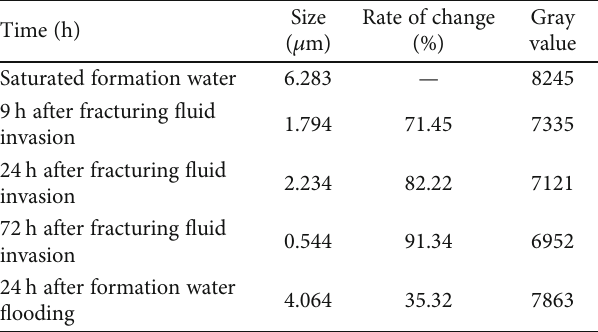
Table 5: Changes of micropore size over